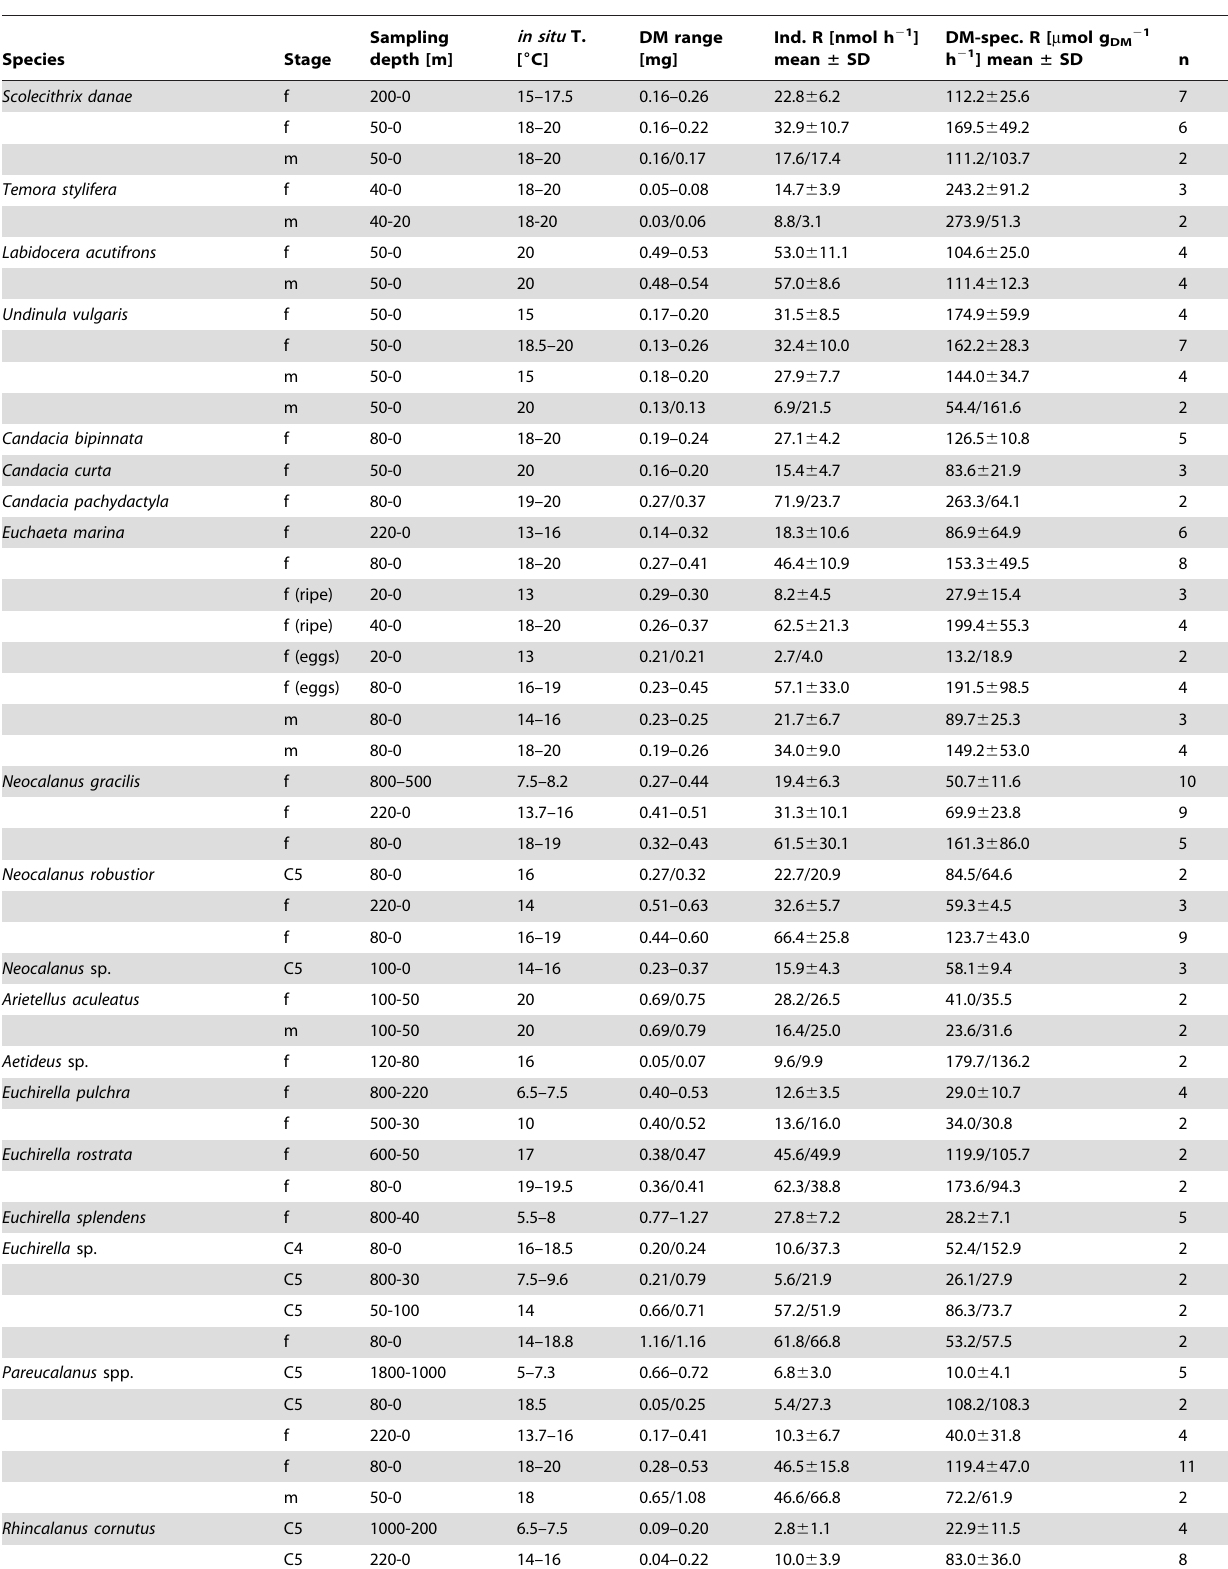
Table 2. Individual and mass-specific respiration rates (mean 6 SD for n $ 3 or range, if n=2) of calanoid copepods from the tropical